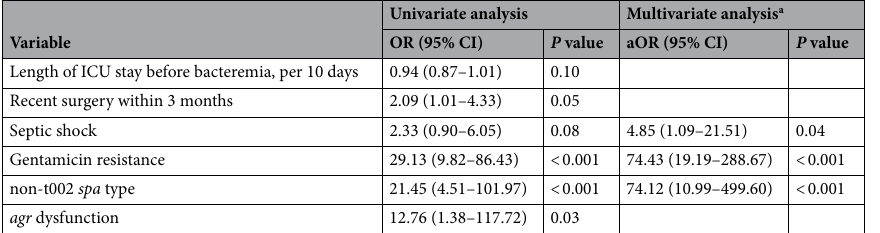
Table 3. Univariate and multivariate analyses of risk factors for presence of qacA/B in ST5-MRSA-II blood isolates. Data are no. (%) of patients, unless otherwise indicated. OR odds ratio, CI confidence interval. a This model fits the data well in terms of discrimination (C-statistic = 0.91) and calibration (Hosmer–Lemeshow goodness-of-fit statistic = 8.62; P = 0.28).